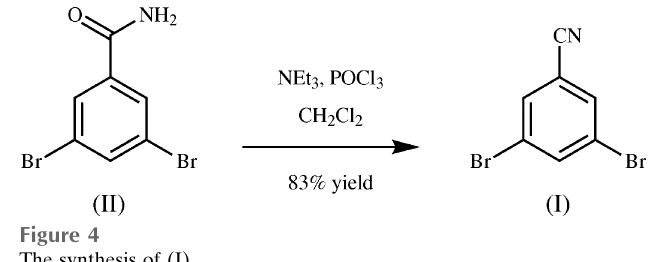
Figure 4 The synthesis of